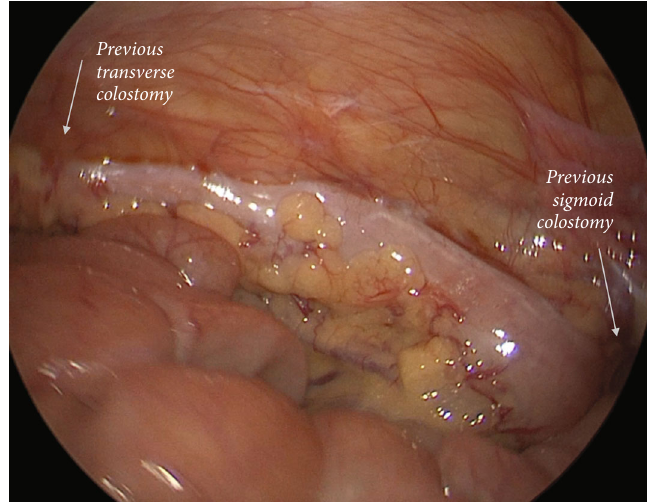
Figure 4: Intraoperative view of the descending colon. Upon inspection, the descending colon was narrow and featureless. The sites of the previous colostomies are